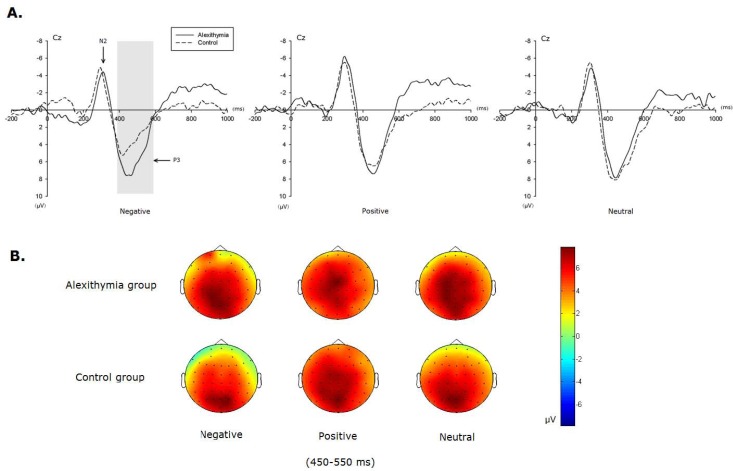
The difference ERPs of Nogo minus Go tasks between two groups during 3 emotional conditions at Cz.A. Difference waveforms recorded at Cz site under 3 emotional contexts (negative, positive and neutral conditions); B. 2-D topographic display of mean voltage of the P3 difference waves (time interval: 450–550 ms) for both alexithymia and control group during 3 emotional conditions.